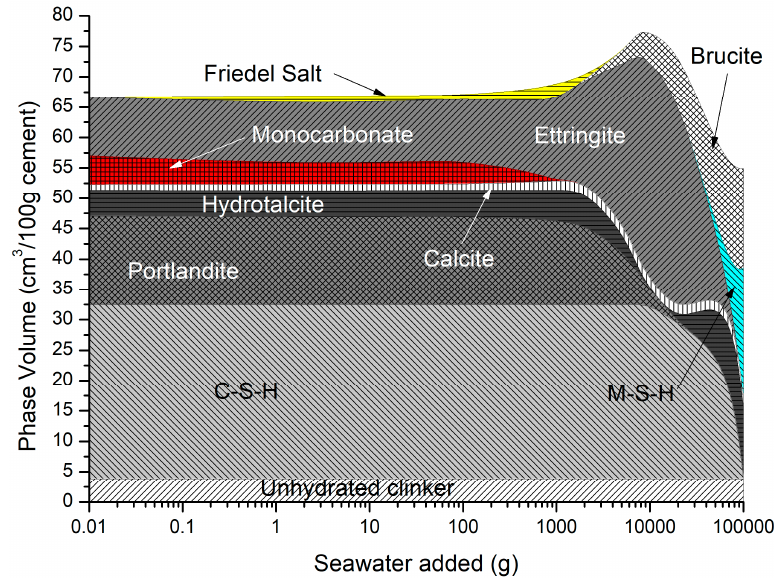
Figure 16. Phase assemblage using North Sea water concentrations reacting with CEM I.